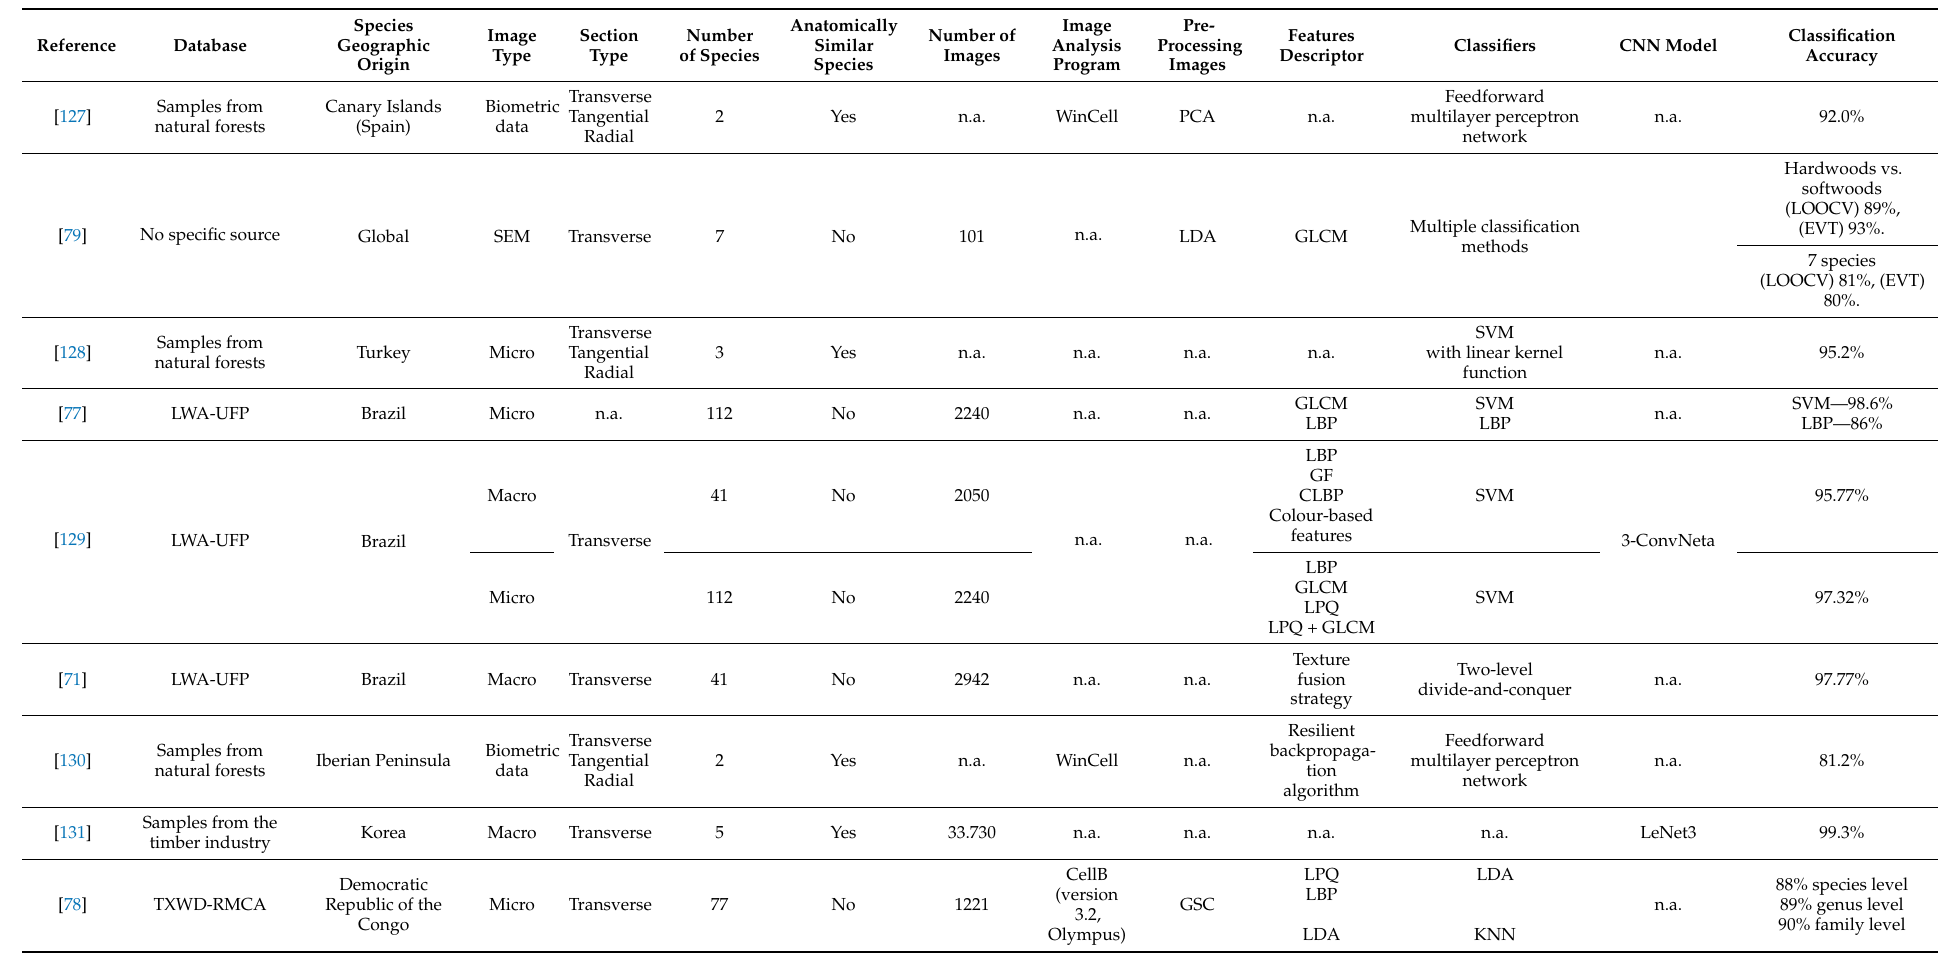
Table 3. Research and applications of deep learning